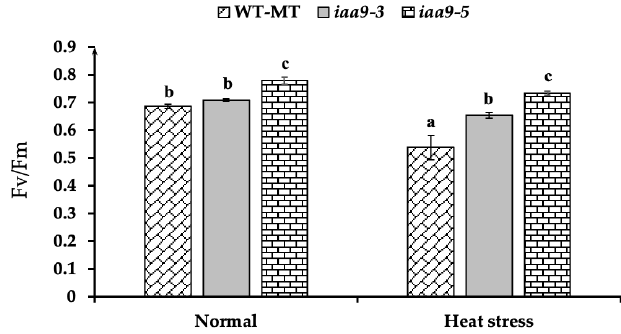
7 of 15 Figure 5. Leaf MDA content of WT-MT, iaa9-3 , and iaa9-5 under normal and heat stress conditions. The average value ± standard error (SE) ( n = 4) followed by the same letter is not significantly dif- ferent according to the Tukey-HSD test at 5%. 2.5. IAA9 Mutants Shown Better Chlorophyll Fluorescence under Heat Stress Conditions Chlorophyll fluorescence (Fv/Fm) was measured to assess the degree of stress-in-